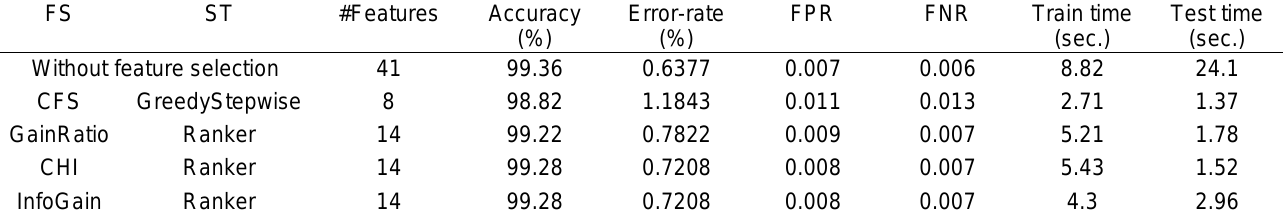
Table 6. Performance evaluation of XGBoost classifier using and without using feature selection techniques on